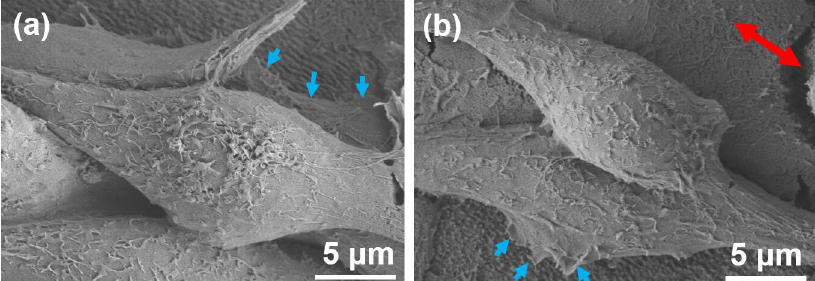
Figure 7. SEM images of osteoblastic MC3T3-E1 cells after cultivation for 7 days with ( a ) the focal adhesions on the nano-ripples; ( b ) the focal adhesions formed perpendicularly to the direction of the nano-ripples. (Lamellipodia and filopodia are indicated with blue arrowheads. The red arrow in ( b ) indicates the direction of the nano-ripples).